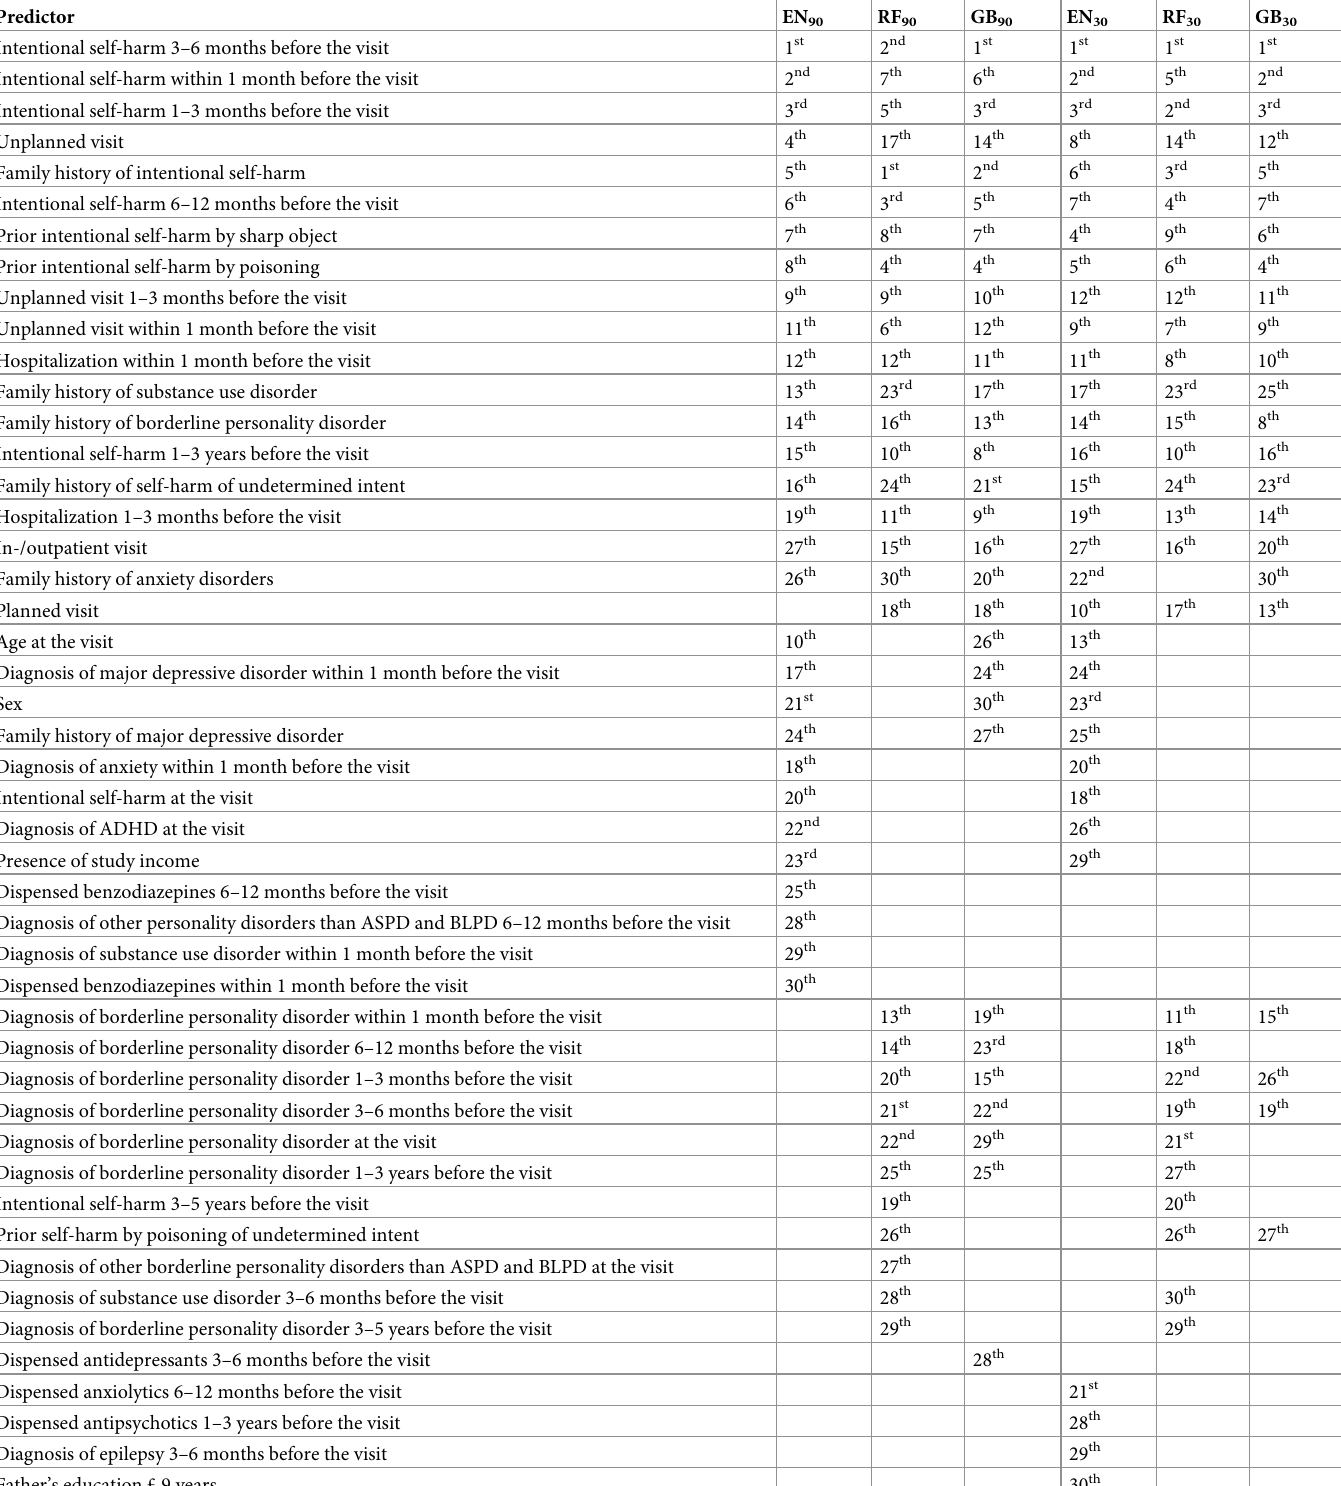
Table 3. Predictors ranked top 30 by the best models of elastic net penalized logistic regression, random forest, and gradient boosting.